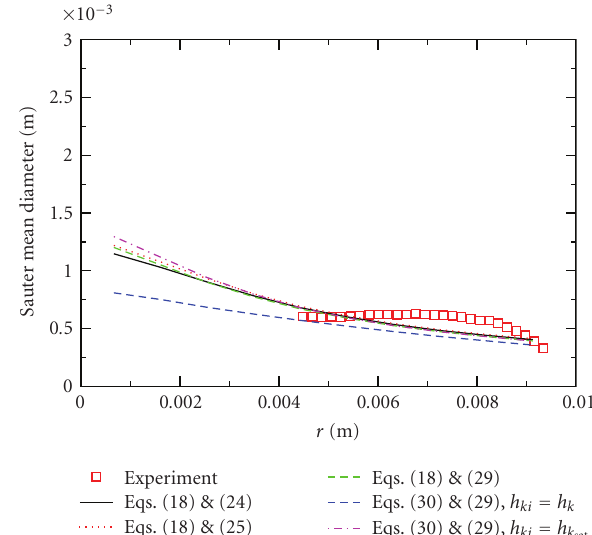
Figure 3: comparison of the di ff erent models on the liquid temperature profile.